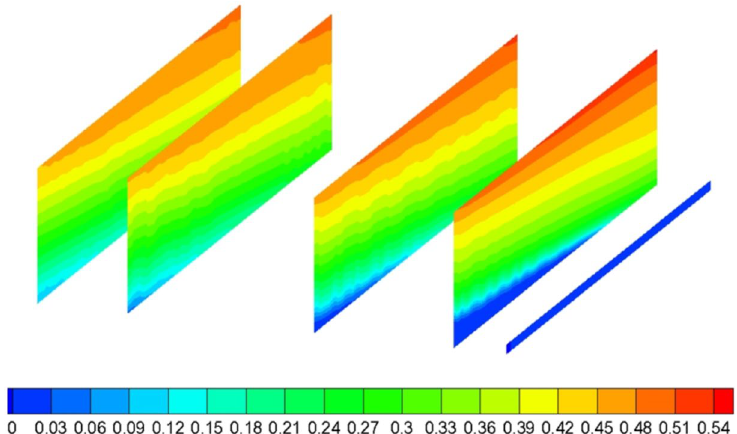
Figure 7. The distribution of gas in the goaf zone (FLUENT 16.0).